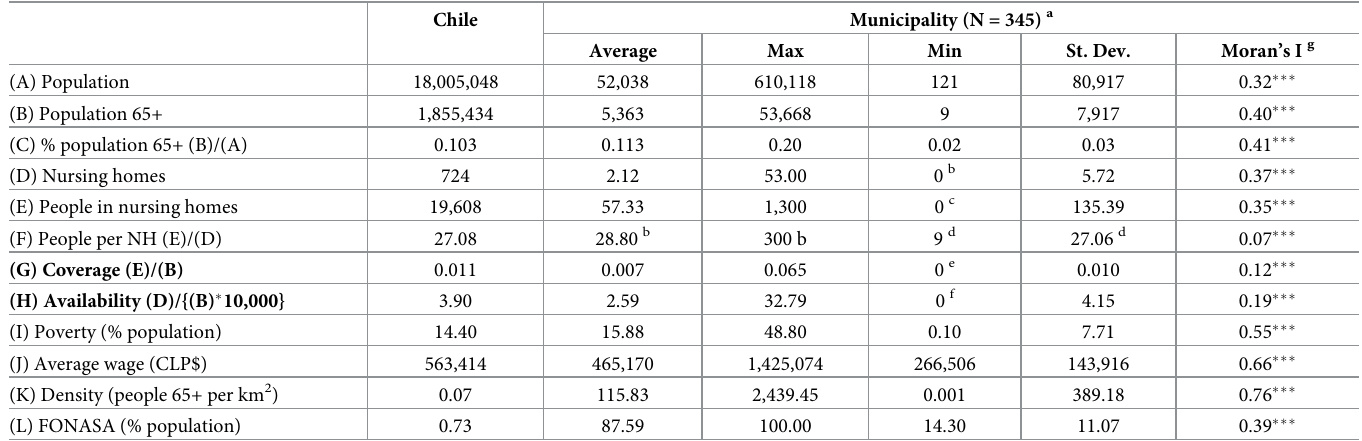
Table 2. Descriptive